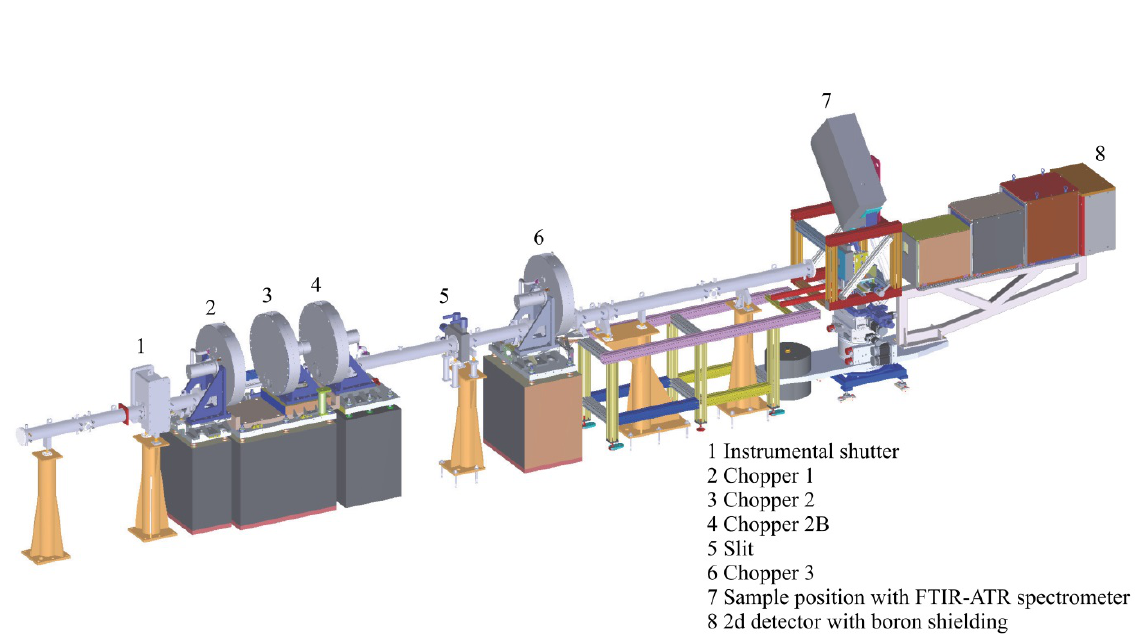
Figure 2: Schematic view of